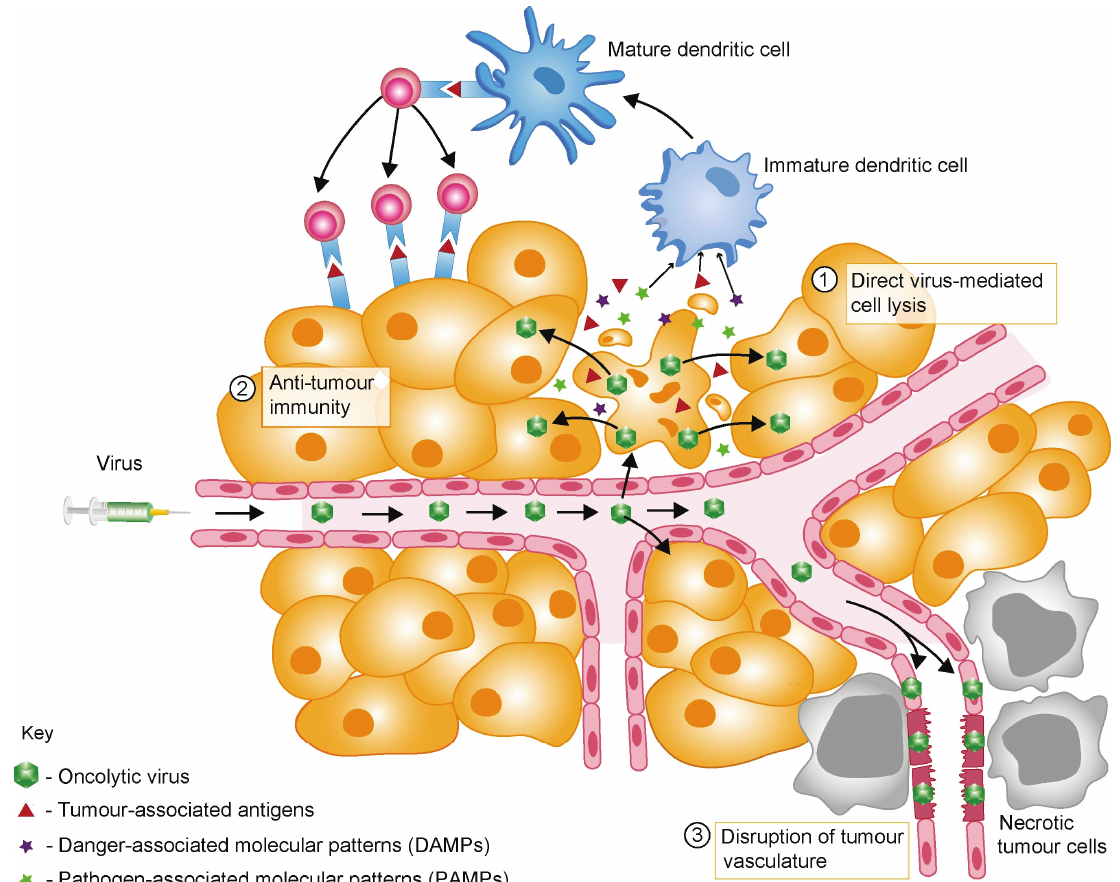
Figure 1. Mechanisms of tumour destruction through oncolytic virotherapy. Oncolytic viruses (OVs) may exert their anti ‐ tumour effects through several mechanisms. OVs induce the death of at least some tumour cells in a direct way by infecting these cells and replicating therein. Progeny virus particles are released and infect neighbouring tumour cells, resulting in amplification of the input OV dose (box 1). OVs often induce an immunogenic cell death (box 2). Tumour ‐ associated antigens, pathogen ‐ associated molecular pattern (PAMPs) and danger ‐ associated molecular patterns (DAMPs) are released from dying tumour cells and come into contact with antigen ‐ presenting cells such as dendritic cells in the tumour microenvironment. Local inflammation, as induced by virus infection, stimulates the maturation of dendritic cells and their migration to draining lymph nodes, where they can present tumour ‐ associated antigens to T cells. Under optimal conditions, this may elicit an anti ‐ cancer CD4 + and CD8 + effector T cell response that has the potential to kill infected and uninfected tumour cells. In addition, some OVs disrupt the tumour ‐ associated vasculature (via infection of tumour endothelial cells, expression of anti ‐ angiogenic viral proteins and/or OV ‐ induced inflammatory responses), leading to ischemia and necrotic death of uninfected tumour cells (box 3).